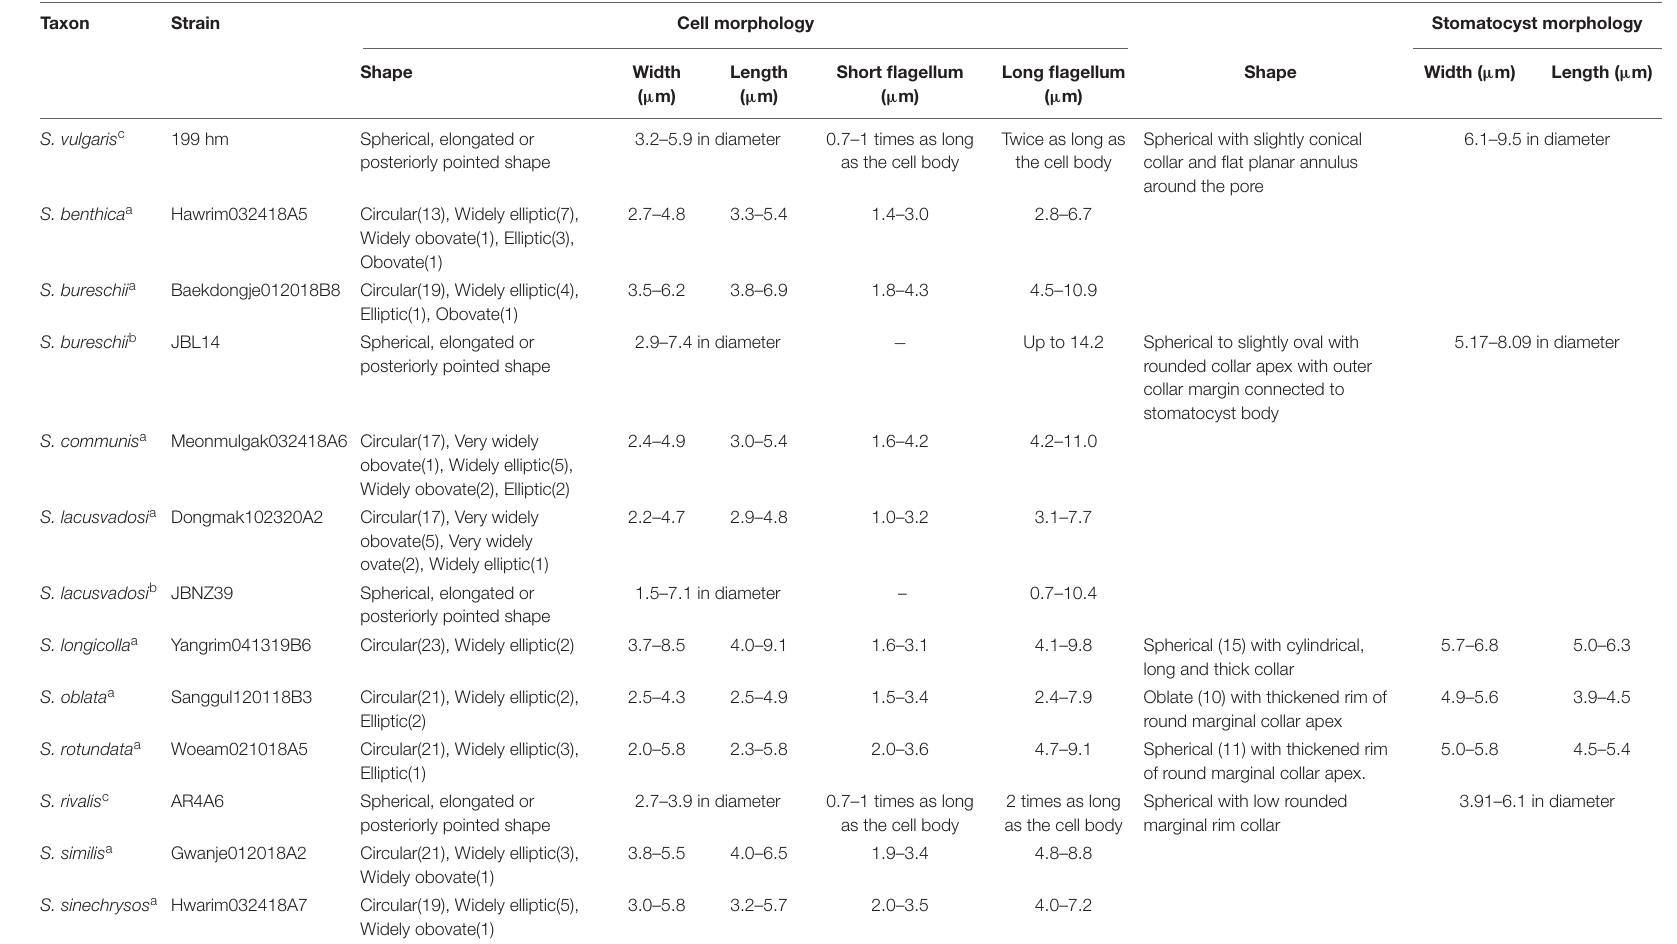
TABLE 1 | Summary of vegetative cell and stomatocyst morphological characteristics of Spumella